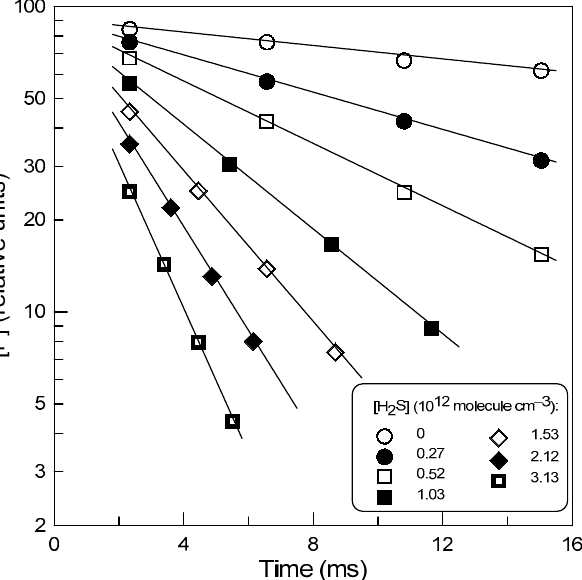
Figure 2. Typical F-atom decay profiles observed in the presence of different concentrations of H 2 S at T = 295 K.